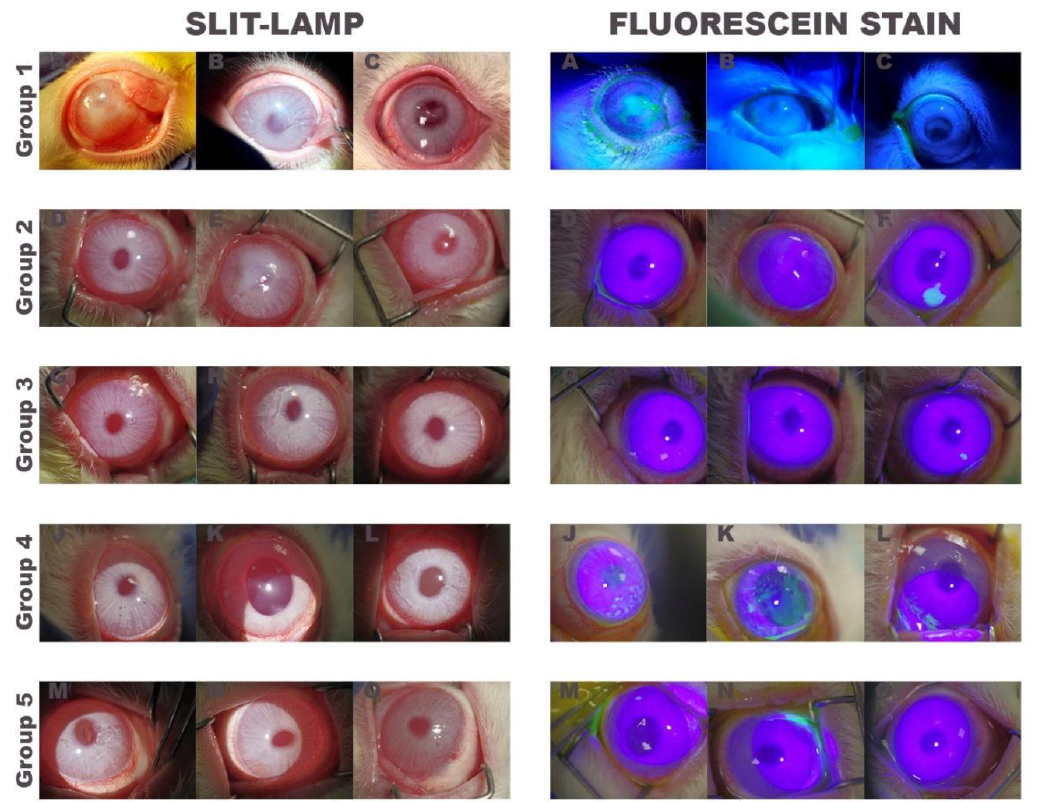
Figure 3. Appearance of rabbit eyes at the end of the follow-up period. Slit-lamp photographs (left) and fluorescein stain photographs (right) of the three treated rabbits of each group. Group 1: only medical treatment (control group), Group 2: fibrin-PRGF membrane cultured with autologous rabbit LEPCs, Group 3: fibrin-PRGF membrane cultured with heterologous rabbit LEPCs, Group 4: fibrin-PRGF membrane SLET and Group 5: fibrin-PRGF membrane without rabbit cultured LEPCs. PRGF: Plasma Rich in Growth Factors; LEPCs: Limbal Epithelial Progenitor Cells; SLET: Simple Limbal Epithelial Transplantation. Table 2. Clinical evaluation of the rabbits on the day of the diagnosis and treatment and at the end of the follow-up period. S0–S4: scores defined in Table 4.